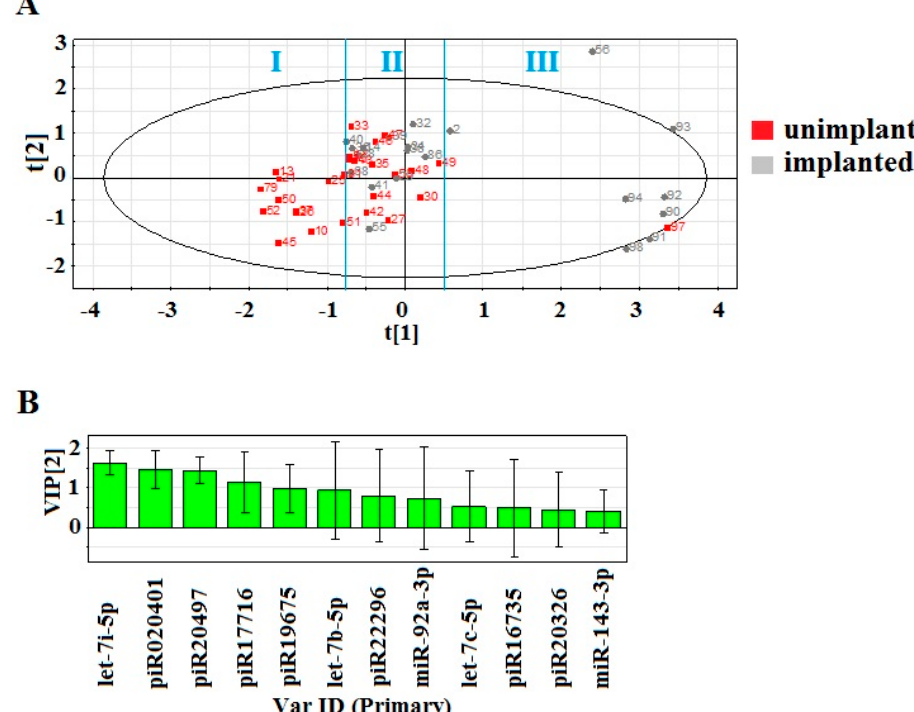
Figure 5. Partial least squares discriminant analysis (PLS-DA) of 2 − ∆∆ Ct RT-PCR data on the expression of sncRNAs in the 48-embryo culture medium samples. Arabic numerals denote the sample number. Roman numerals (I, II, III) denote the cluster of samples depending on the result of embryo transfer into the uterine cavity and the profile of RNA expression in the cultivation medium. ( A ) score plot with the imposition of information of the sncRNA expression level on the results of embryo transfer into the uterine cavity, ( B ) Variable Importance in Projection (VIP) score.